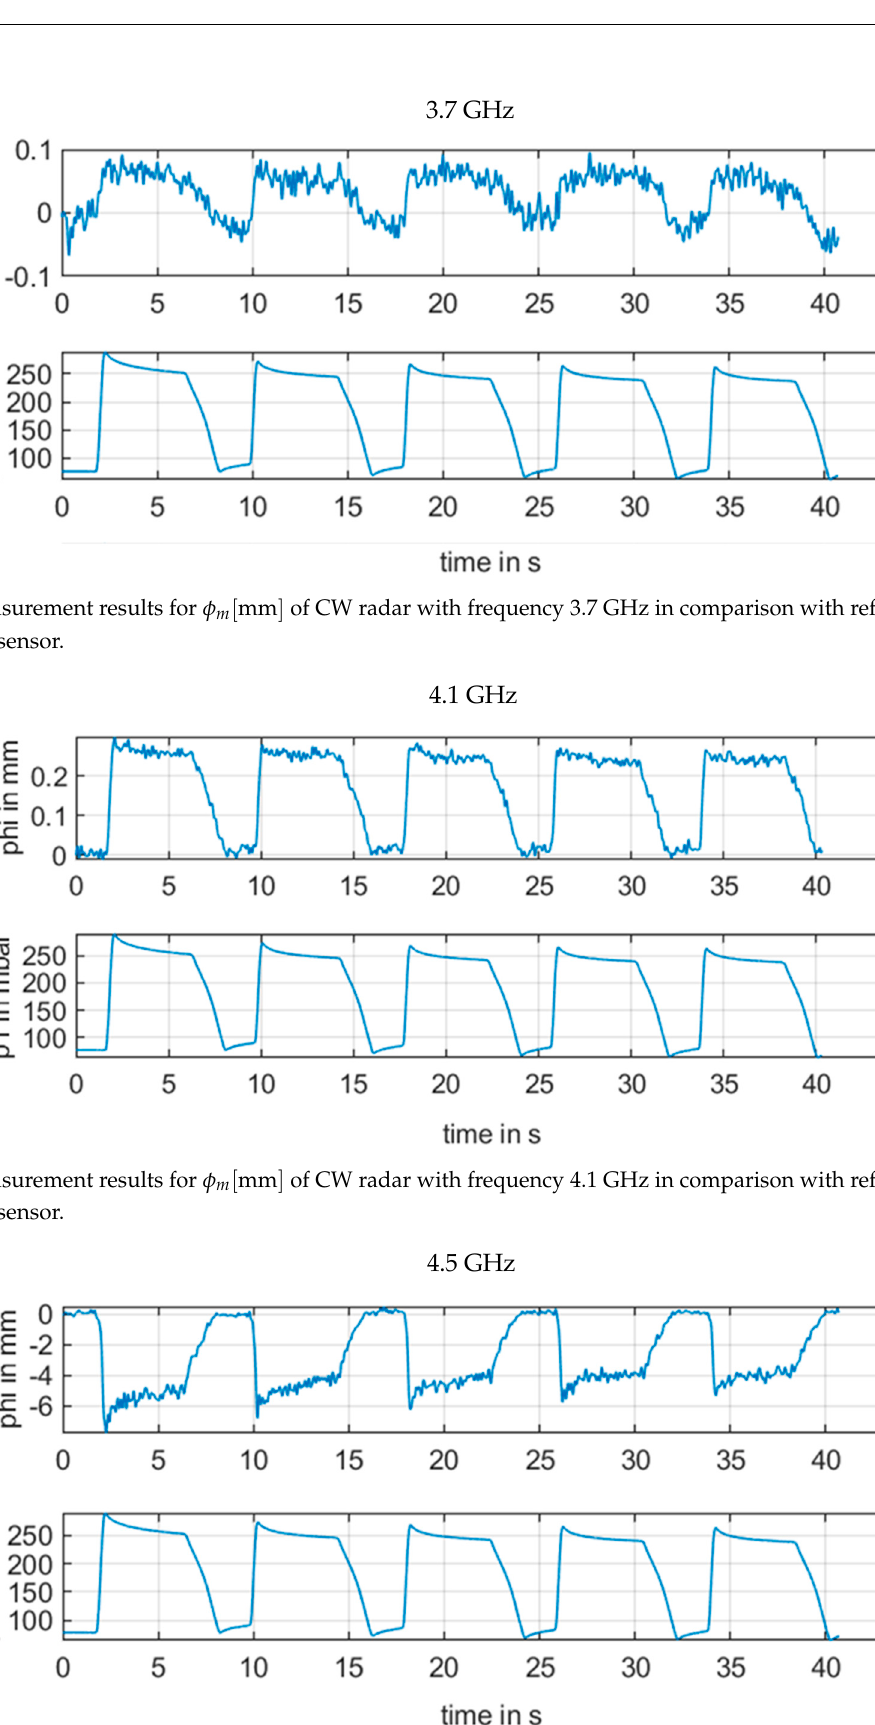
Figure 14. Measurement results for φ m [ mm ] of CW radar with frequency 4.5 GHz in comparison with reference pressure p1 from pressure sensor.